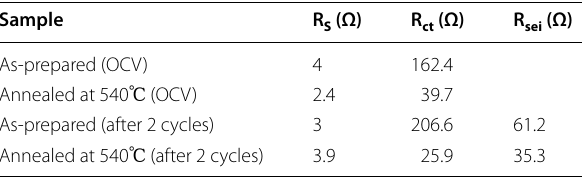
Table 1 Fitting values of the electrochemical